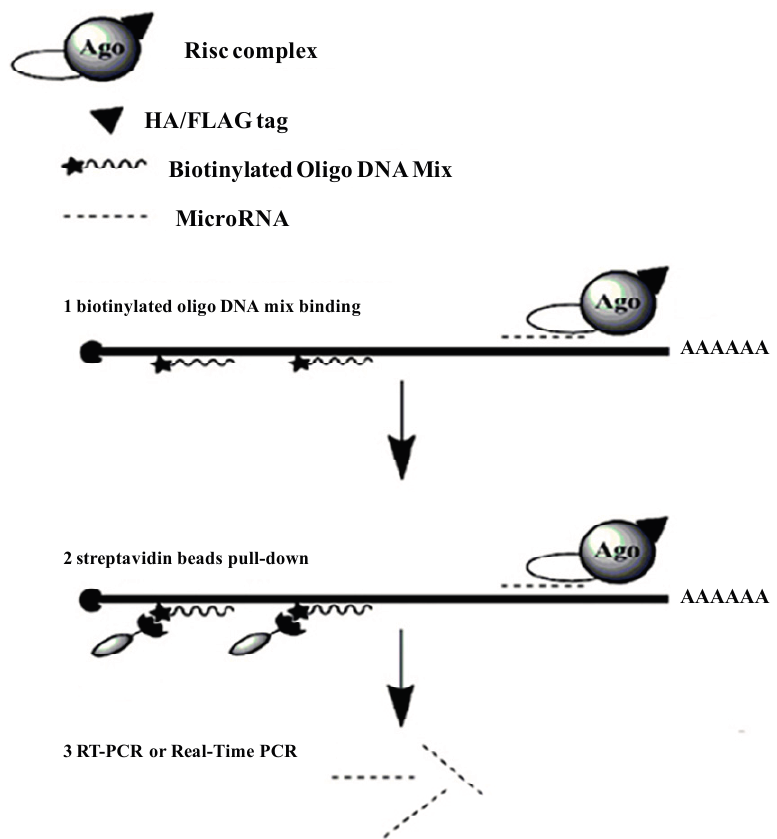
Figure 1. The pull-down strategy of the determination of the microRNAs (miRNAs) that target to a specific gene. Extracts from the cells that over-expressed a tagged Argonaute protein are first incubated with biotinylated oligo DNA mix, and then affinity purified